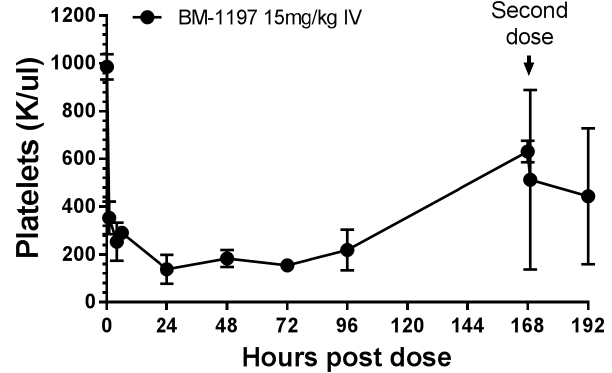
Figure 11. BM-1197 decreases platelet count in mice. BM-1197 was administered by IV bolus injected into the tail vein. At the indicated time points the mice were euthanized and blood was drawn for complete blood count. Data are mean 6 SEM (n=3).